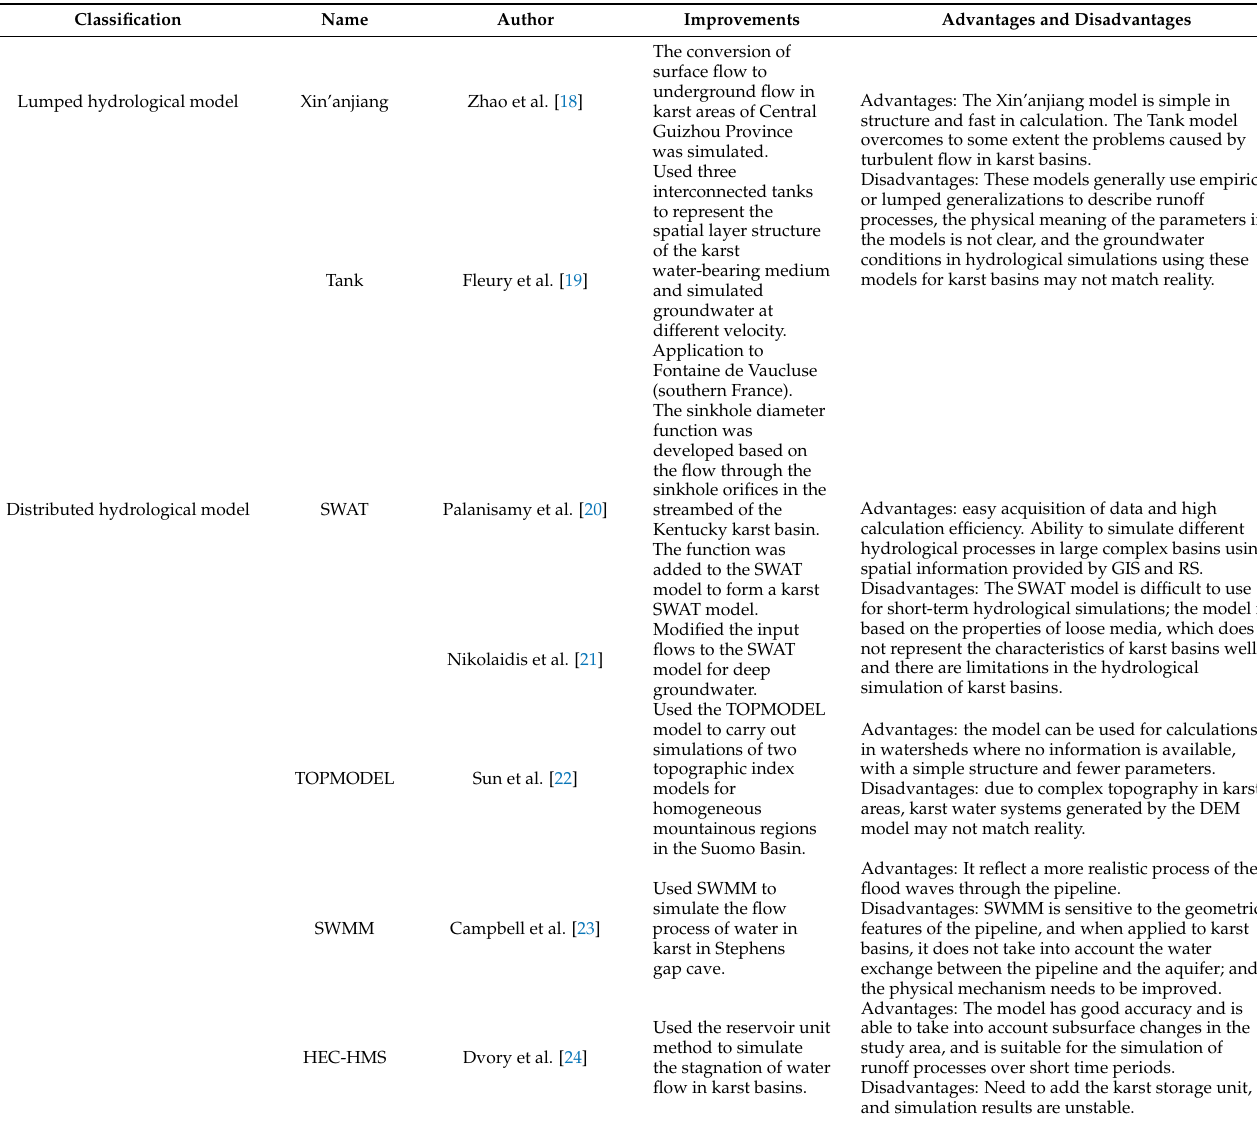
Table 1. Application of hydrological models to karst